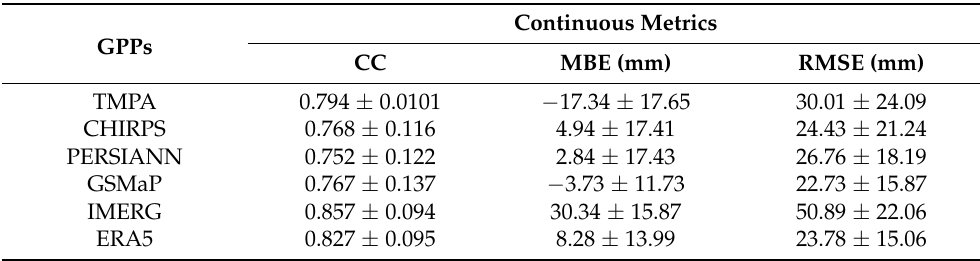
Table 3. Continuous metrics calculated from monthly accumulated precipitations values of the GPPs and synoptic stations at the station level.